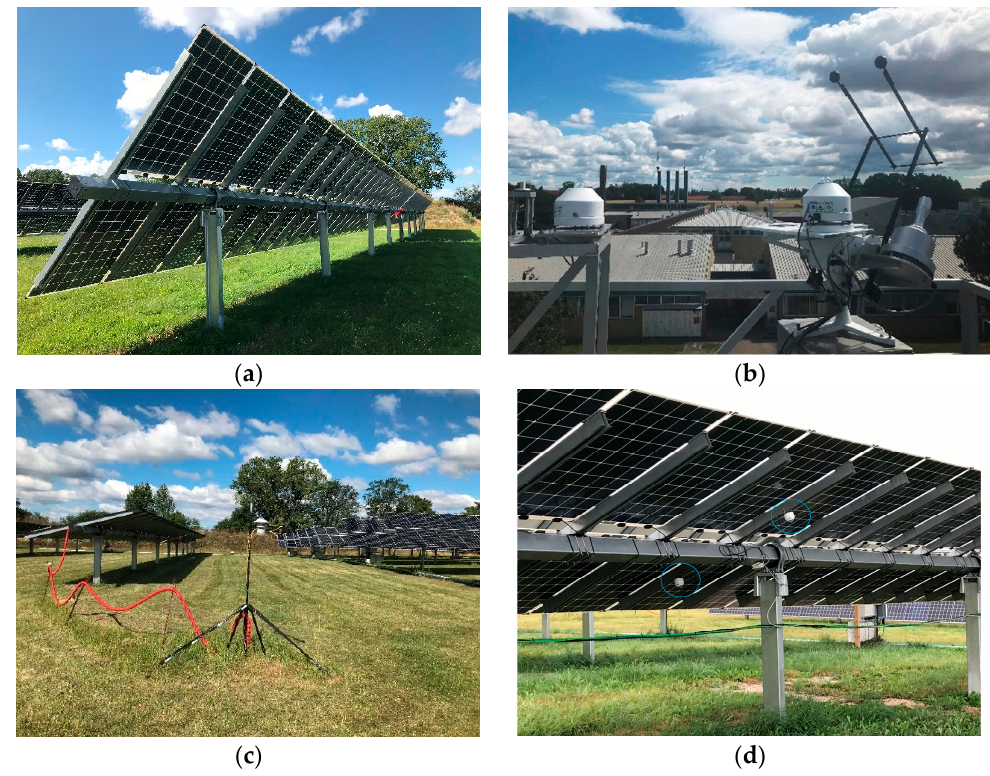
Figure 2. ( a ) Ground-level view of the bifacial HSAT system; ( b ) Onsite solar radiation monitoring tower where the broadband global horizontal (GHI), diffuse horizontal (DHI), and direct normal irradiance (DNI) measurements are recorded. ( c ) Onsite albedometer. ( d ) Two rear plane of array pyranometers (top and bottom circled in blue) on the fixed-tilt bifacial system; Sensors are placed 17 m from the nearest array edge.